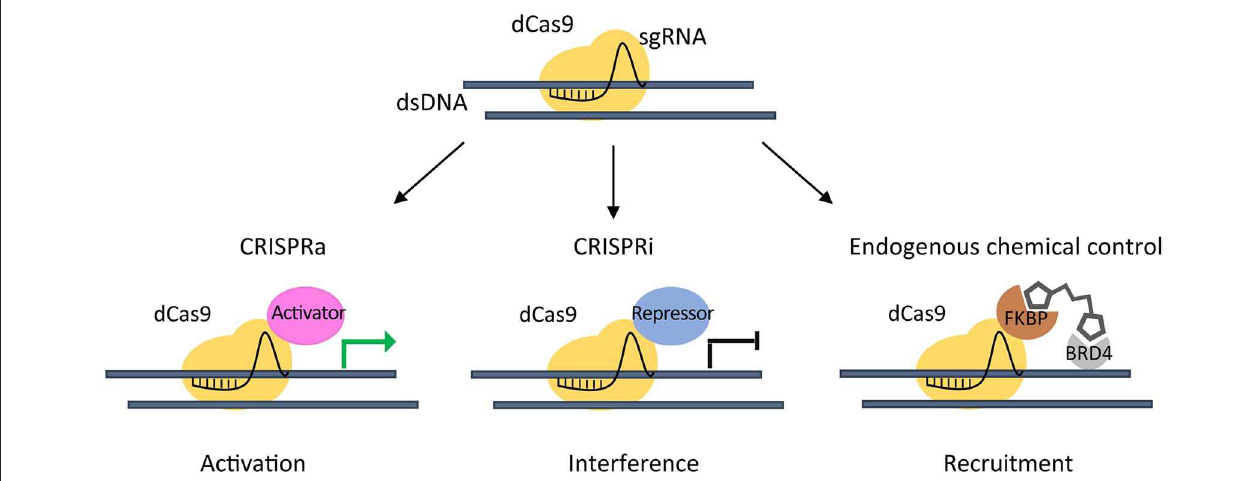
FIGURE 2 | CRISPR/dCas9 chromatin engaging approaches. Inactive (dead) dCas9 is tethered to an activating domain (CRISPR activation- CRISPRa) that can potentially induce activation of a target gene (green arrow) (left), or to a repressive domain (CRISPR interference - CRISPRi) that can interfere gene expression (black arrow) (middle). A dCas9-FKBP fusion protein is used to recruit Chemical Epigenetic Modifiers (CEM) small molecules, in order to engage the endogenous BRD4 to a target gene